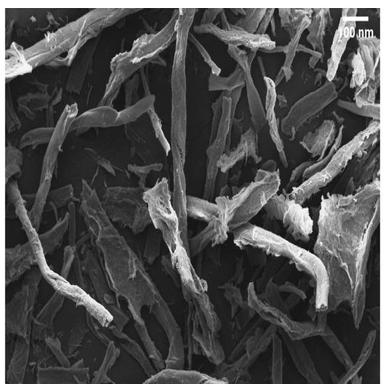
SEM micrographs of CNCs. Fig. 4. XRD pattern of CNCs.